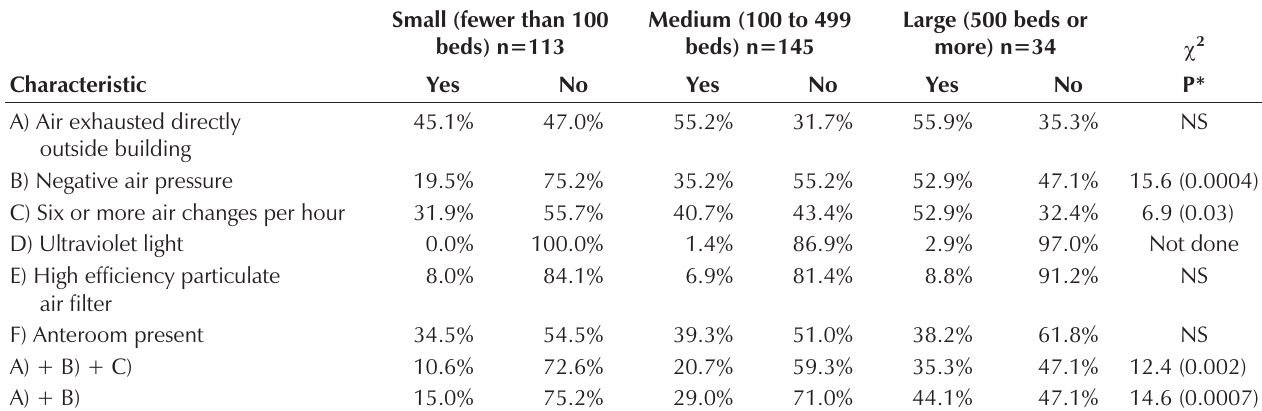
Percentage of ward isolation room environmental and engineering controls in small, medium and large acute care